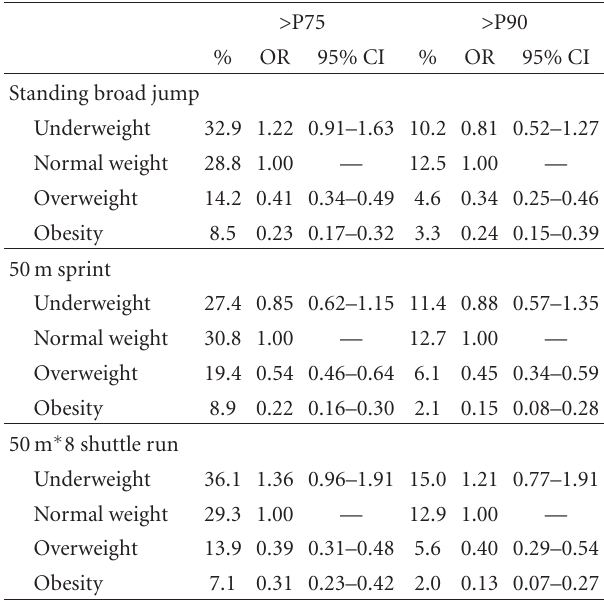
Table 4: Proportion of children with test result above the age- and gender-specific 75th percentile (P75) and 90th percentile (P90) by body weight